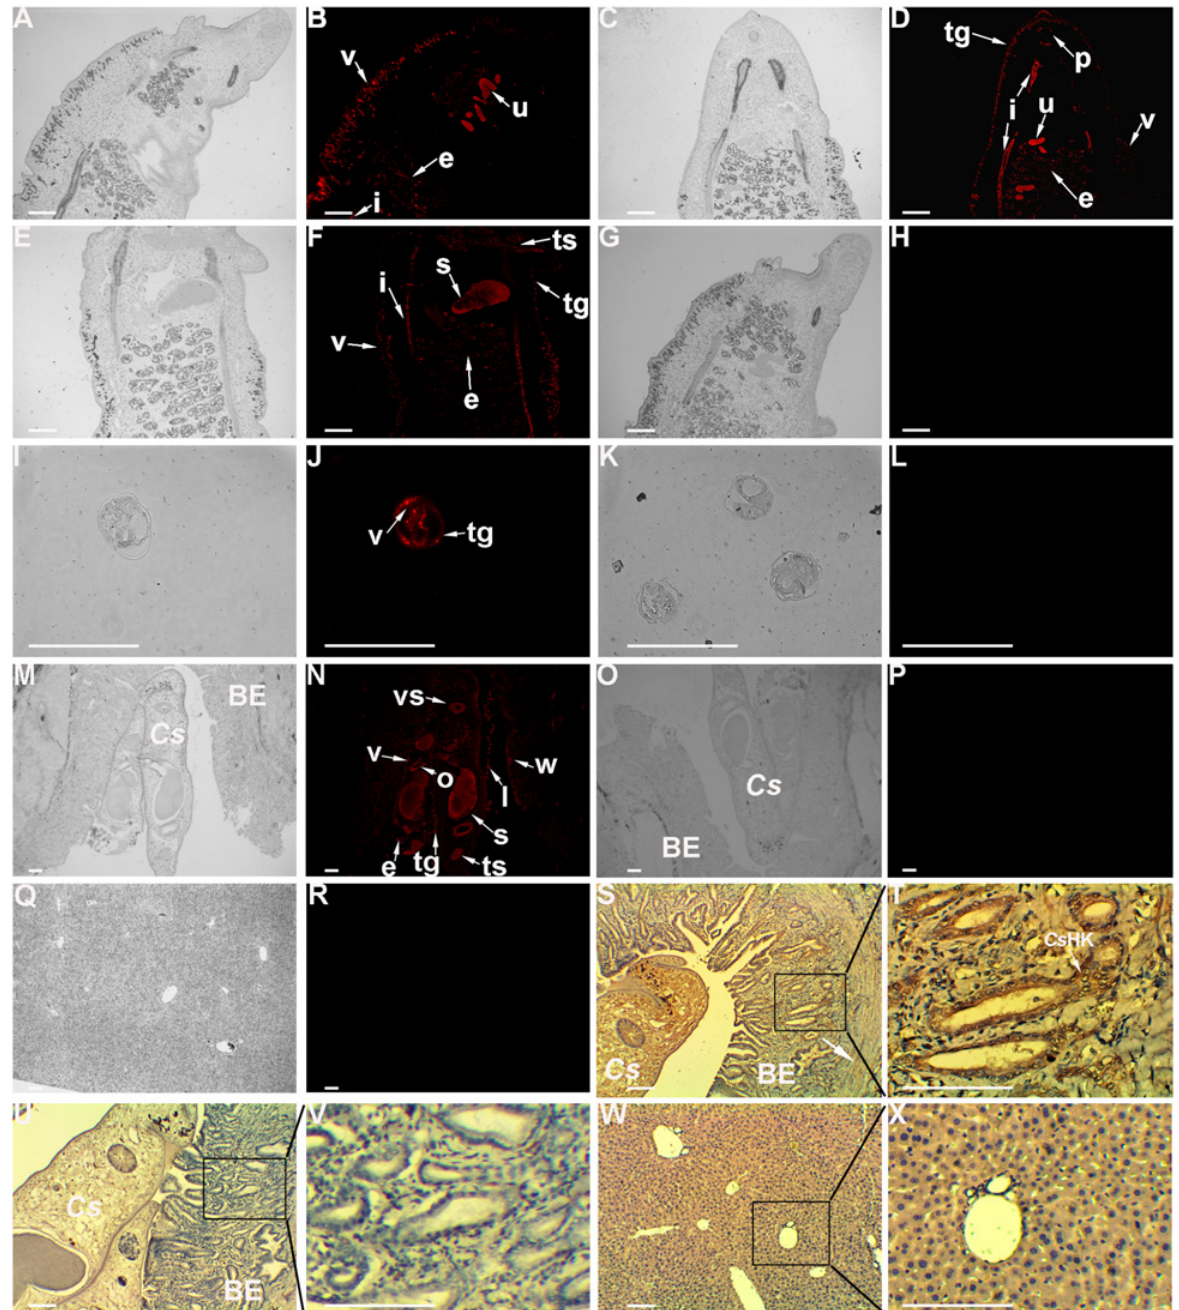
Fig 4. Immunolocalization of Cs HK in C . sinensis and in liver from infected rats. Mouse anti-r Cs HK serum and anti-mouse IgG were applied as primary antibody and secondary antibody, respectively. Serum from pre-immune mice was employed as primary antibody for a negative control. Panels H, L, P, R, U, V, W, and X are negative controls. Panels B, D, F, H, J, L, N, P, and R are under fluorescence microscope and the same parts (panels A, C, E, G, I, K, M, O, and Q) are under white light. Panels B, D, and F, localization of Cs HK in adult worms; panel J, localization of Cs HK in metacercariae. Panels S and T, localization of Cs HK in intrahepatic bile ducts of a C . sinensis infected rat. In panels S, T, U, V, W, and X, peroxidase staining shows as a yellow/rust colored deposit and Mayer ’ s hematoxylin counterstains the nuclei in light purple. White arrows highlight the regions of intrahepatic bile duct tissue and the tissue that stained positive for Cs HK. Original magnification: × 50 for panels M, N, O, P, Q and R; × 100 for panels A, B, C, D, E, F, G, H, S, U, and W; × 400 for panels I, J, K, L, T, V, and X. Bar = 800 μ m. v, vitellarium; e, egg; vs, ventral sucker; tg, tegument; i, intestine; u, uterus; ts, testicle; o, ovary; p, pharynx; s, spermatheca; l, lumen; w, within the cells; Cs , C . sinensis ; BE, biliary epithelium.